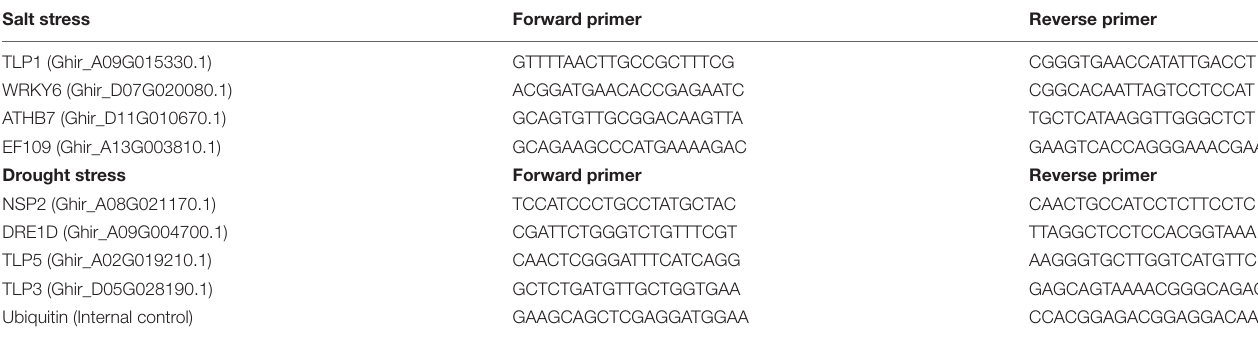
TABLE 2 | A list of primers used for validation in qRT-PCR. Salt